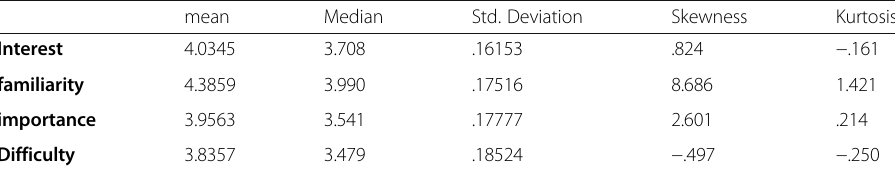
Table 6 Descriptive Statistics for Learners ’ Perception of the Self-Selected Topics mean Median Std. Deviation